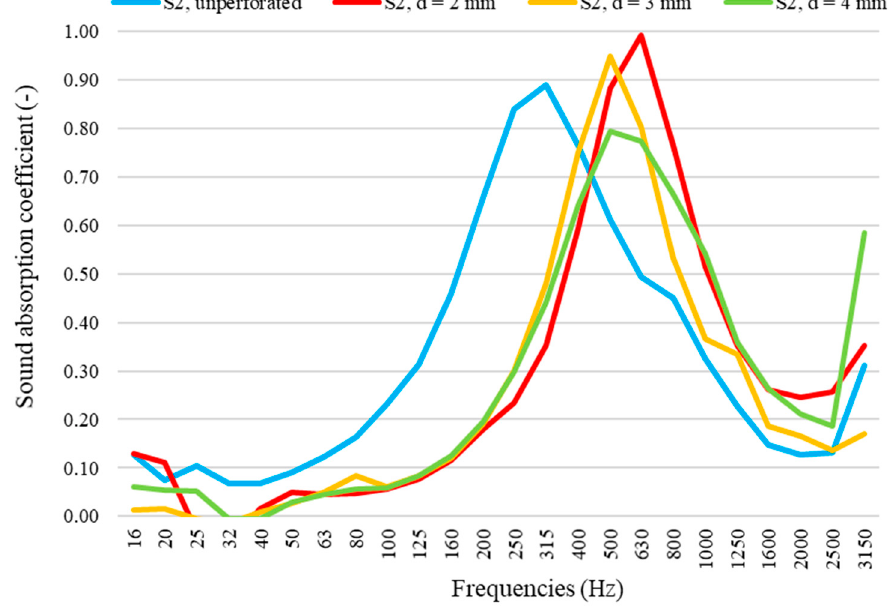
Figure 5. Sound absorption coefficient variation with different perforation diameters (sample S 2 ).